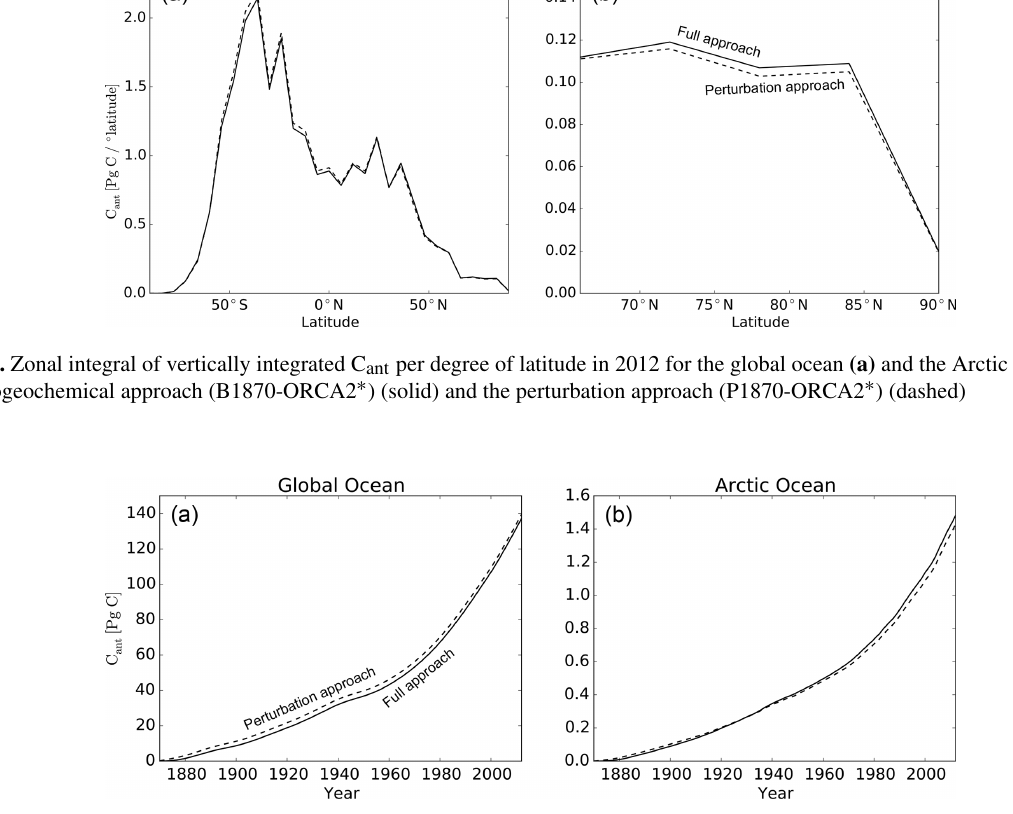
Figure A3. Arctic Ocean C ant inventory in the global ocean (a) and the Arctic Ocean (b) for the full biogeochemical approach (B1870- ORCA2 ∗ ) (solid) and the perturbation approach (P1870-ORCA2 ∗ )